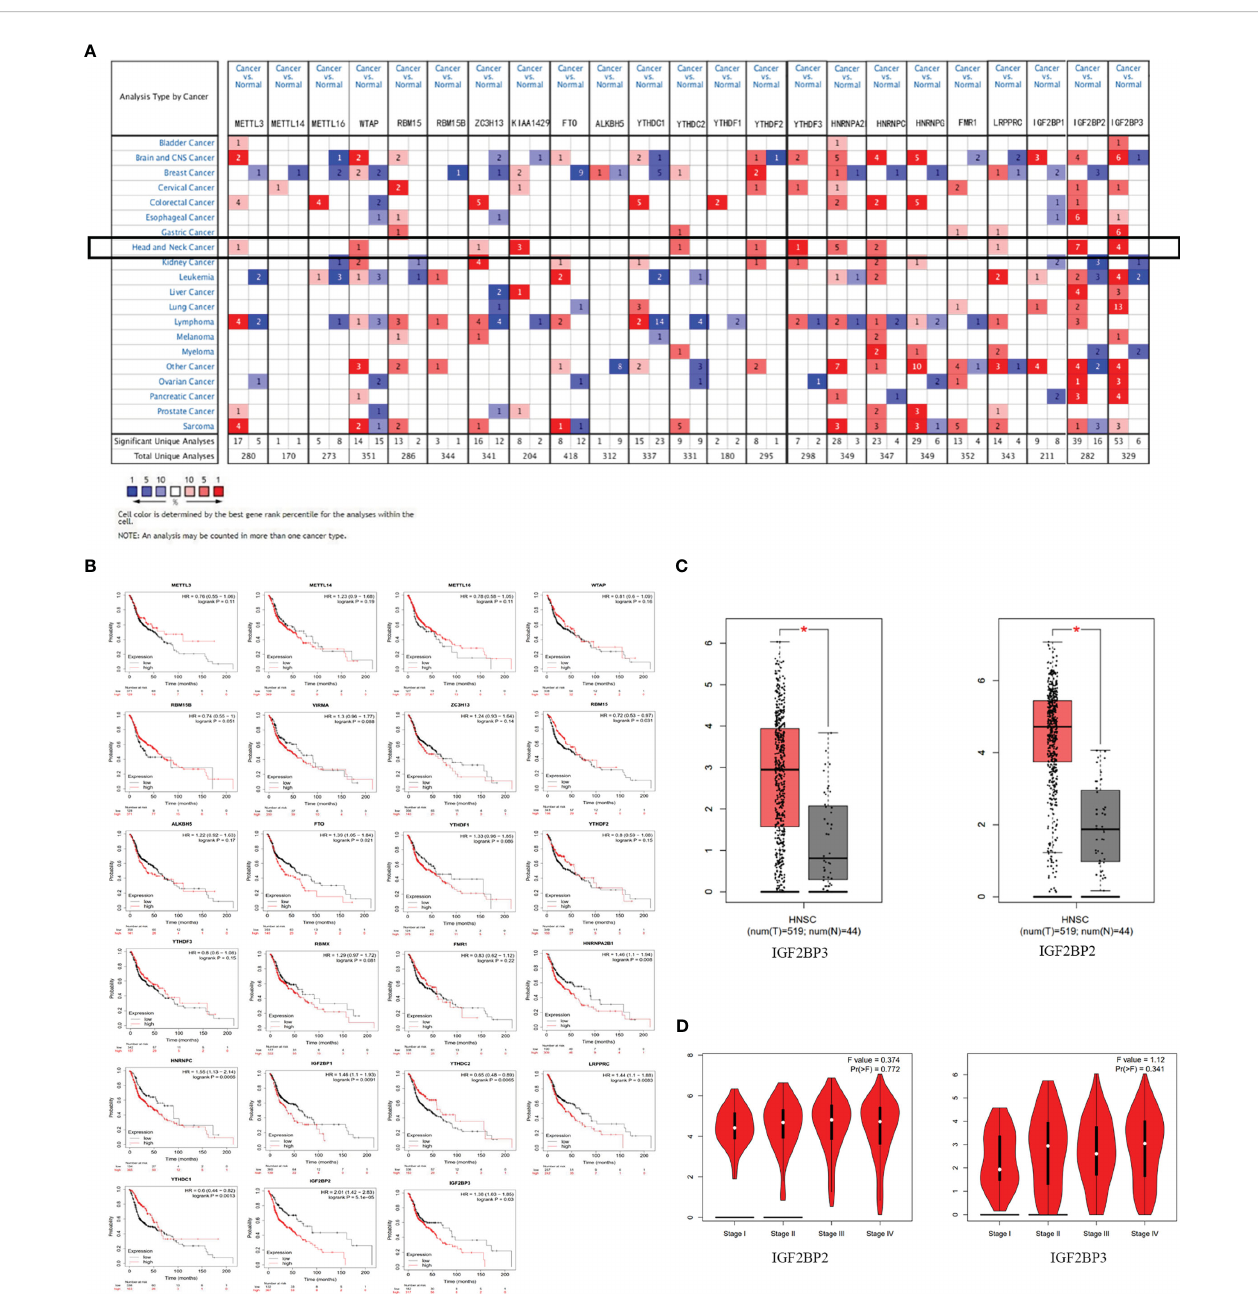
FIGURE 1 m6A and its regulatory genes abnormally expressed in head and neck squamous cell carcinoma (HNSCC). (A) An integrated analysis of 23 m6A methylation regulators by searching the Oncomine database. (B) The correlation between m6A methylation regulators and HNSCC prognosis supported by the data from Kaplan-Meier Plotter database. (C) The expressions of IGF2BP2 and IGF2BP3 were upregulated in HNSCC by searching the GEPIA database. (D) No signi fi cant difference between IGF2BP2 and IGF2BP3 in different stages of HNSCC ( P >0.05) from the data of GEPIA